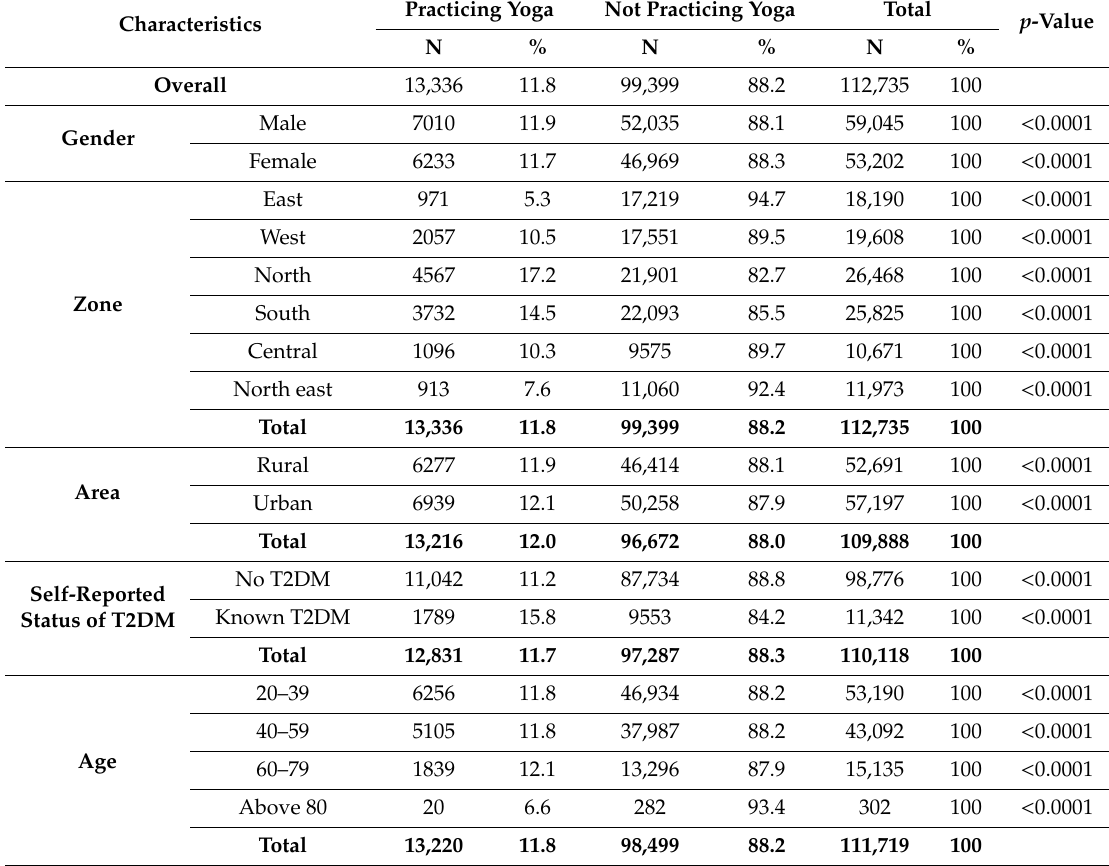
Table 3. Socio-demographic distribution of practitioners of yoga in